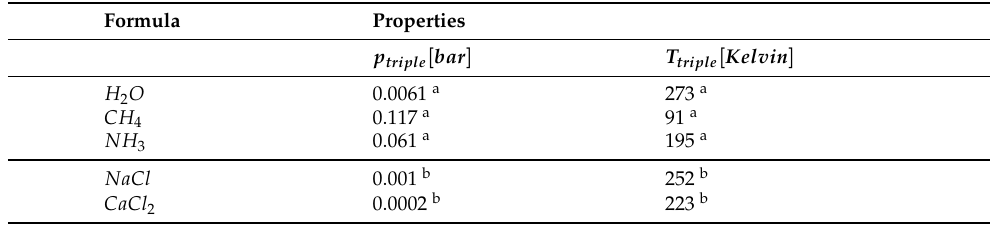
Table A1. Triple point (equivalent)